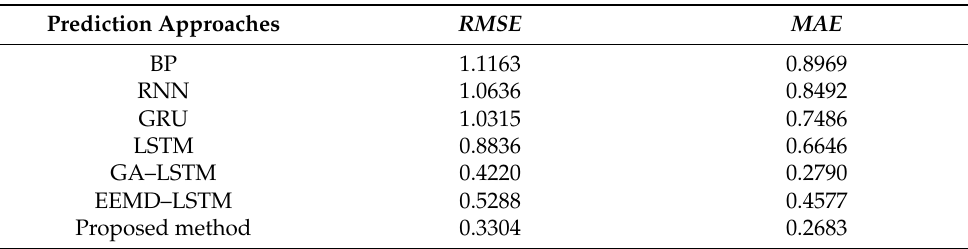
Table 2. Evaluation results of predictive capacity (evaporation duct).